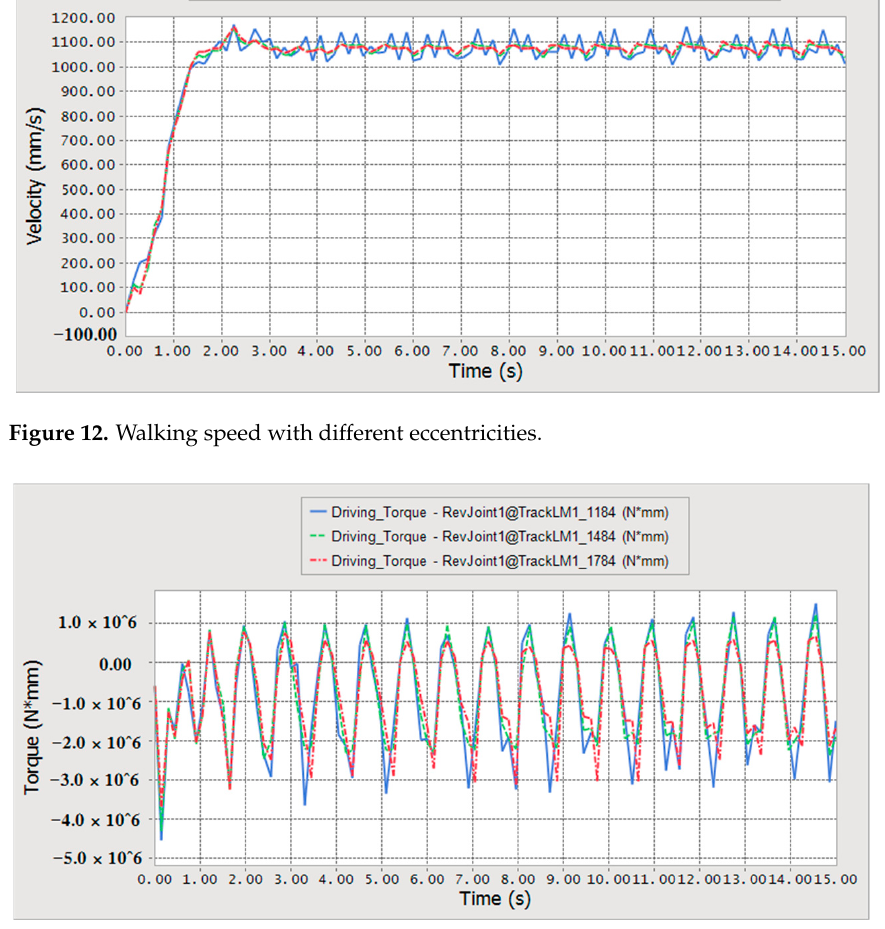
Figure 13. Driving torque with different eccentricities.